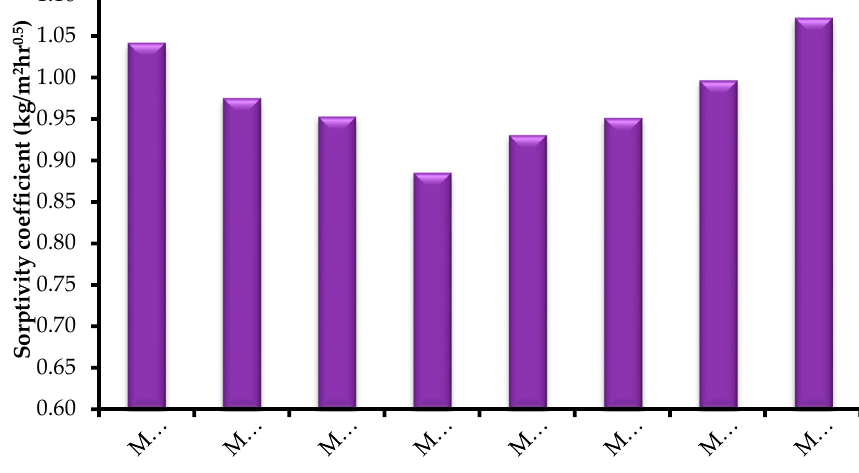
Figure 8. Sorptivity coefficient.